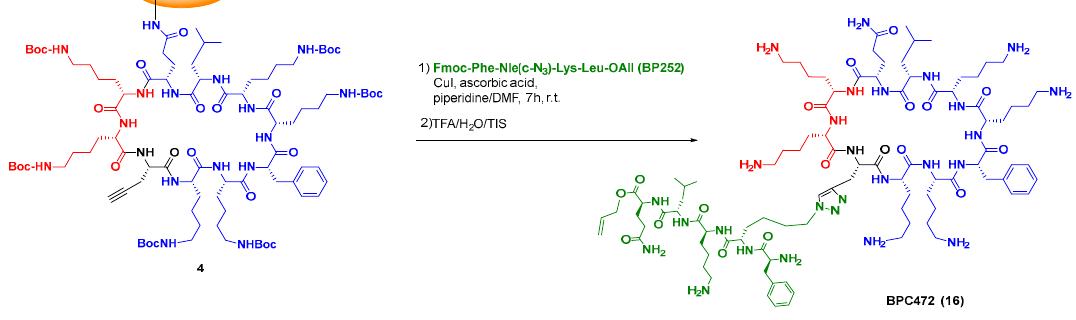
Scheme 7. Peptide ligation using click’ chemistry.